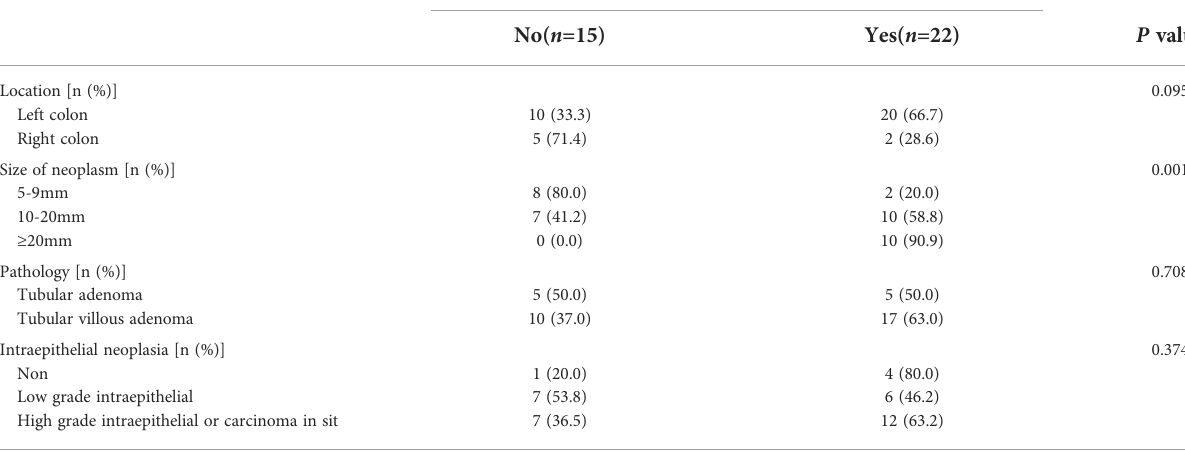
TABLE 5 Factors in fl uencing the detection of high-risk adenomas by 18 F-FDG PET/CT. Whether PET/CT shows high risk adenoma FDG